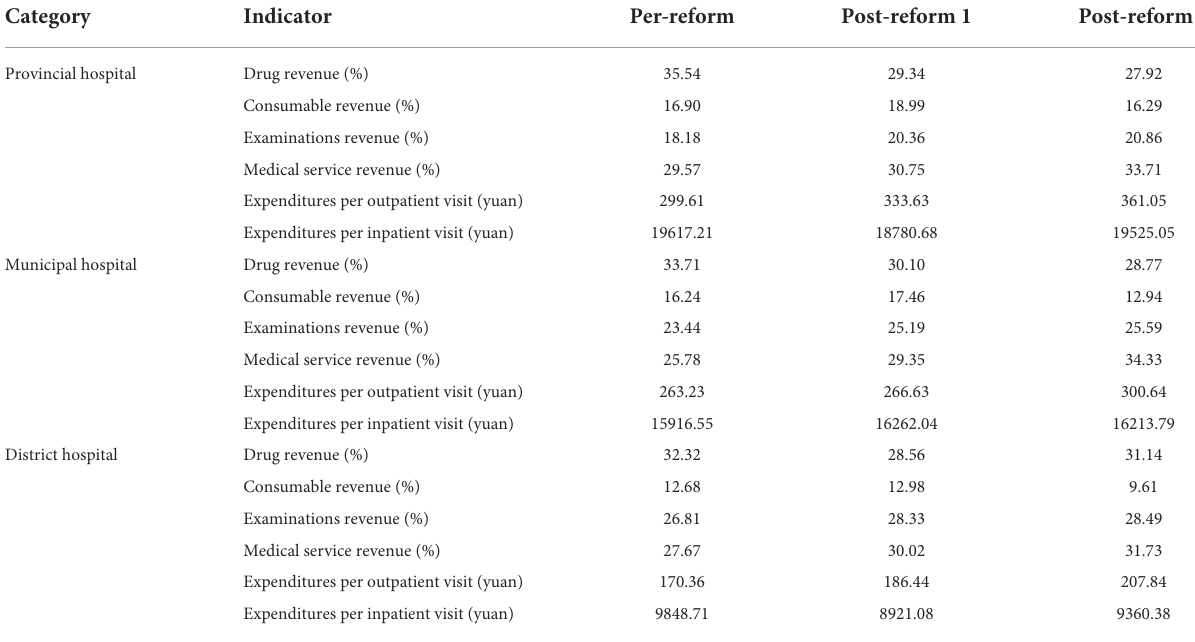
TABLE 1 Monthly mean of outcome variables before and after reforms by provincial, municipal, and district hospitals.